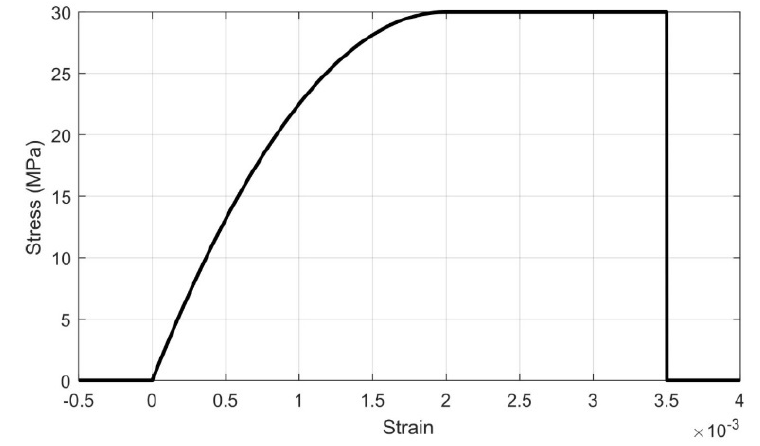
Figure 6. Stress-strain relation for concrete with f c =